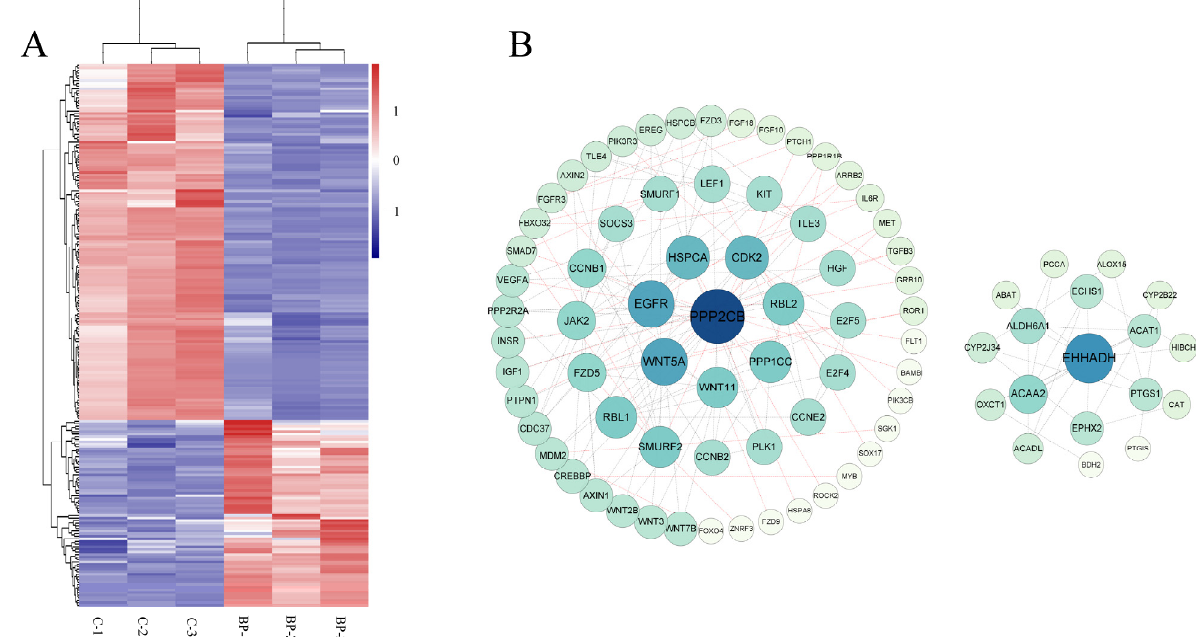
Figure 6. Characterization of differentially expressed mRNAs (DEmRs) involved in fat-related pathways. ( A ) Heatmap cluster of DEmRs involved in fat-related pathways. ( B ) The protein-protein interaction network of DEmRs involved in fat-related pathways. The size of the circle indicates the degree of interaction between the genes. The network was constructed with score > 0.9, FDR stringency = 1 percent, and disconnected nodes were hide.